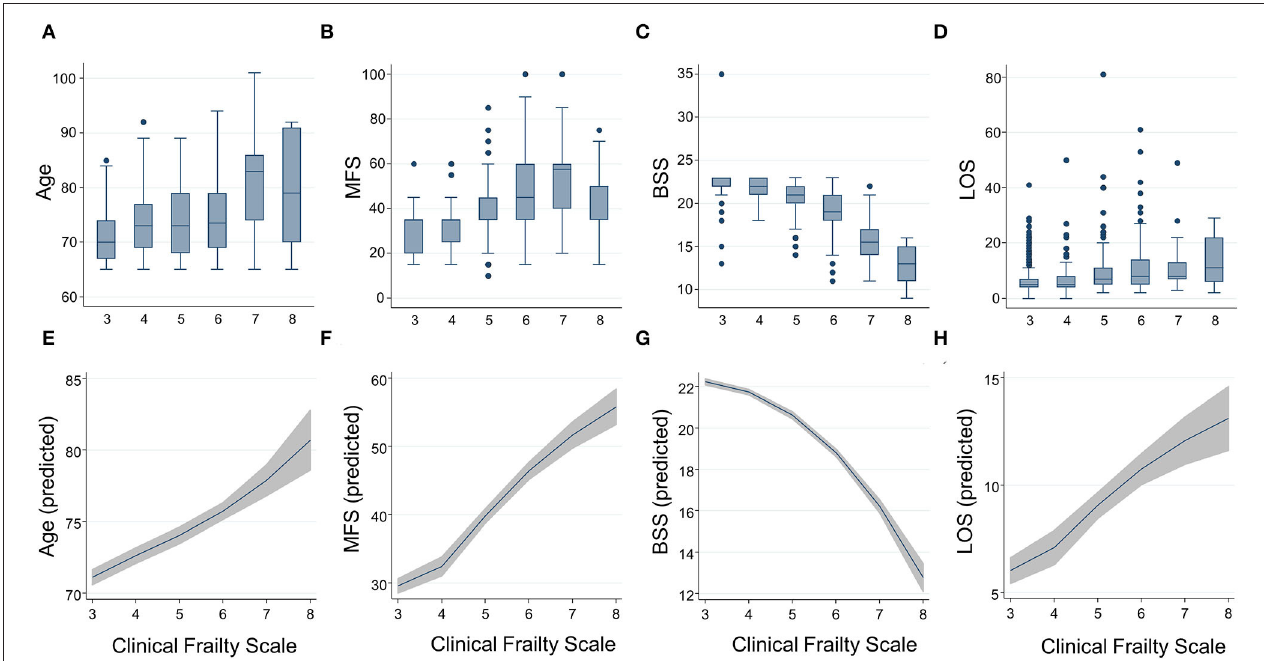
FIGURE 1 | Distributions by box and whisker plots and predicted means by fractional polynomial plots with 95% CIs for age (A,E) , the Morse Fall Scale (B,F) , the Braden Sore Scale (C,G) , and length of stay (D,H) according to the Clinical Frailty Scale. BSS, Braden Sore Scale; LOS, length of stay; MFS, Morse Fall